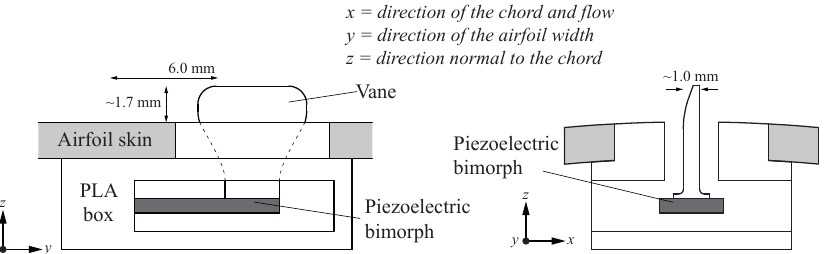
Figure 7. Schematic representation of a piezoelectric bimorph sensor mounted underneath the airfoil skin. The vane pierces the skin to transfer the oscillations from the boundary layer to the piezoelectric